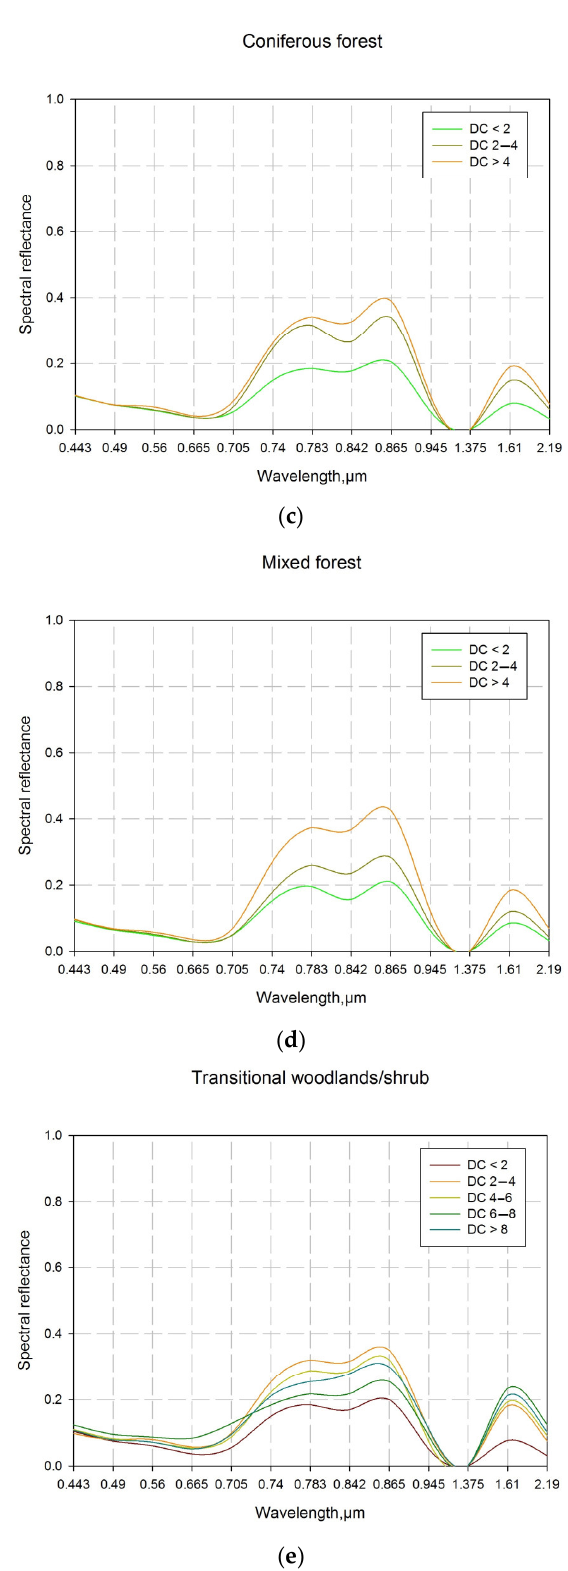
Figure 11. Spectral profiles of the individual land cover classes (LCCs) differently affected by drought: ( a ) pastures and natural grasslands; ( b ) broadleaved forests; ( c ) coniferous forests; ( d ) mixed forests; ( e ) transitional woodlands/shrubs. The Drought coefficient (DC) classes presents the differently affected by drought point locations (point-based validation).